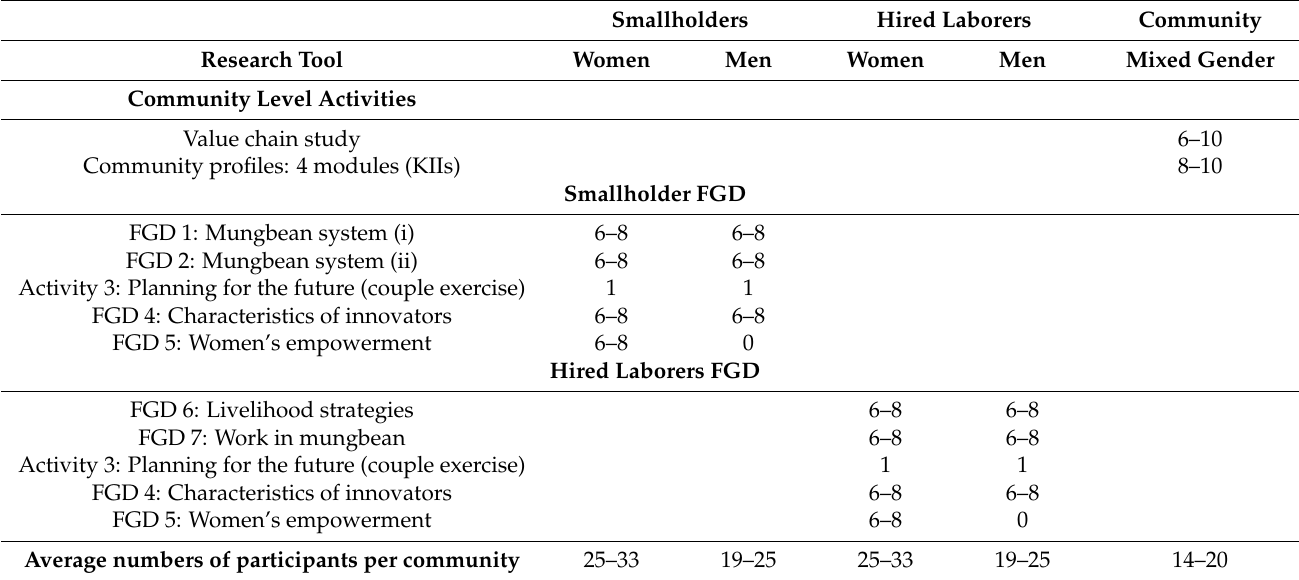
Table 2. Qualitative research tools applied in Myanmar and Bangladesh, showing the average numbers of participants per